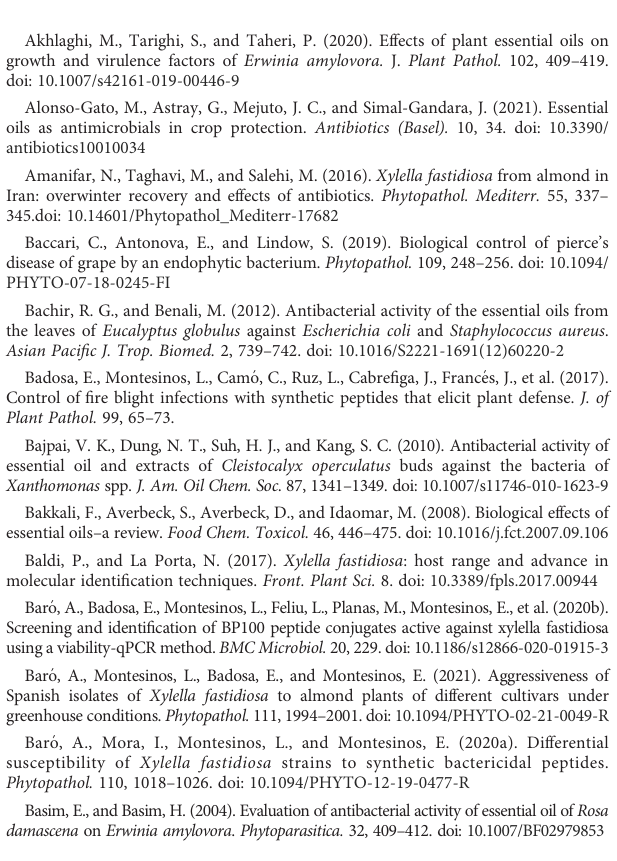
SUPPLEMENTARY FIGURE 1 Effect of EGL2 treatment strategies on X. fastidiosa subsp. fastidiosa